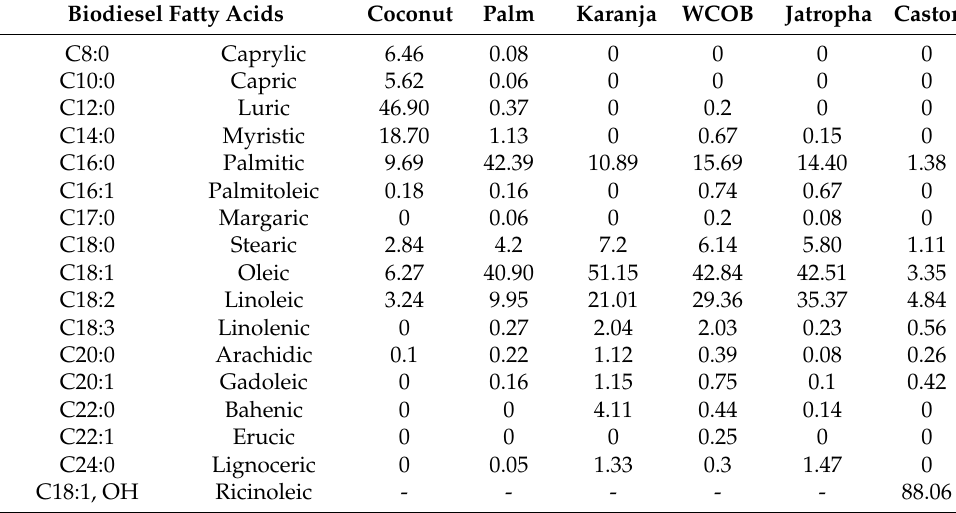
Table 5. FAME composition of various